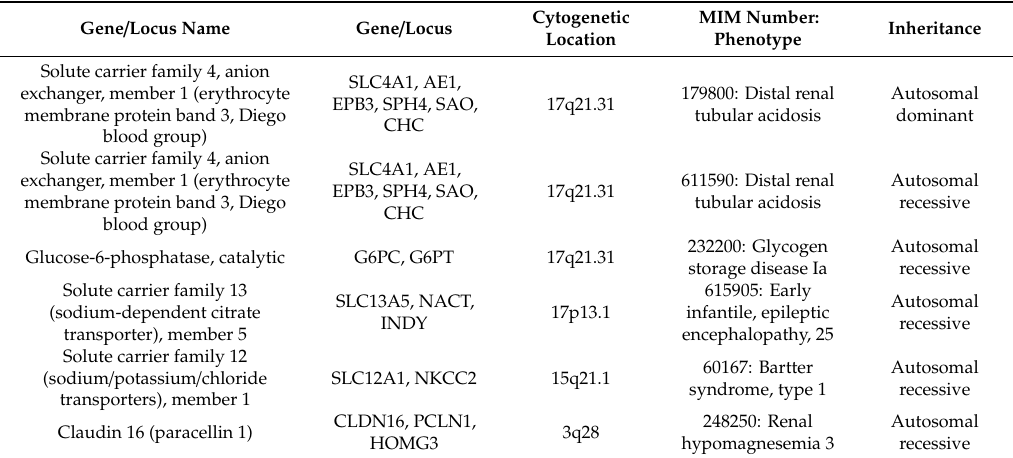
Table 2. Genes involved in the regulation of citrate homeostasis with a genotype / phenotype relationship regarding skeletal development and / or bone metabolism (retrieved from the OMIM ® database, last access 25 May